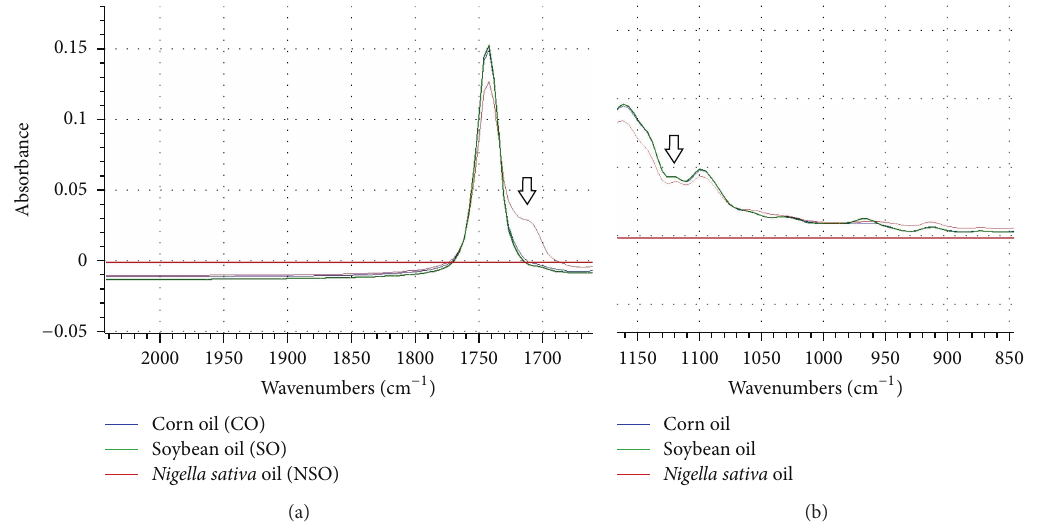
Figure 2: The magnified FTIR spectra frequency region of 1750–1700 cm −1 (a) and at 1128–1084 cm −1 (b). x -axis = wavenumbers (cm −1 ), and y -axis = absorbance.